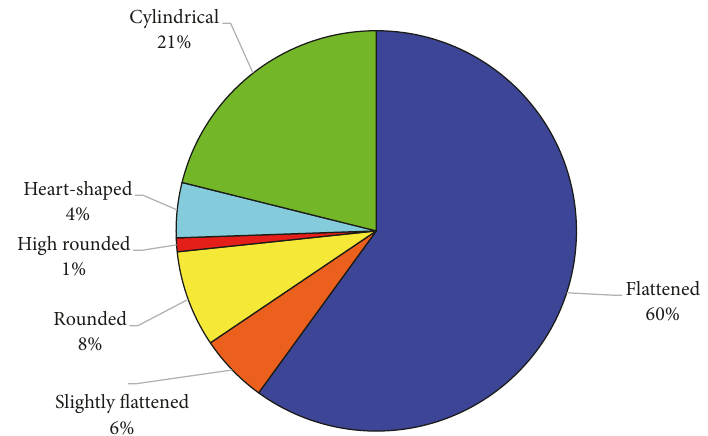
Figure 14: Distribution of ninety-one fresh-market tomato genotypes based on fruit